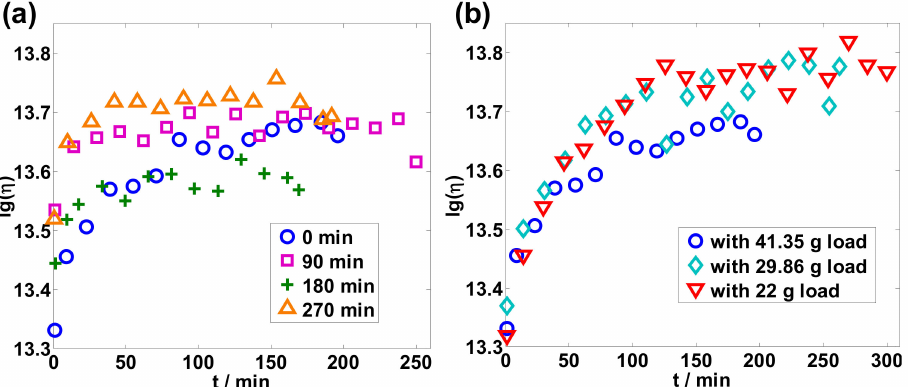
Figure 3. Logarithmic plot of viscosity: ( a ) Viscosity for di ff erent preannealing times; ( b ) viscosity with di ff erent